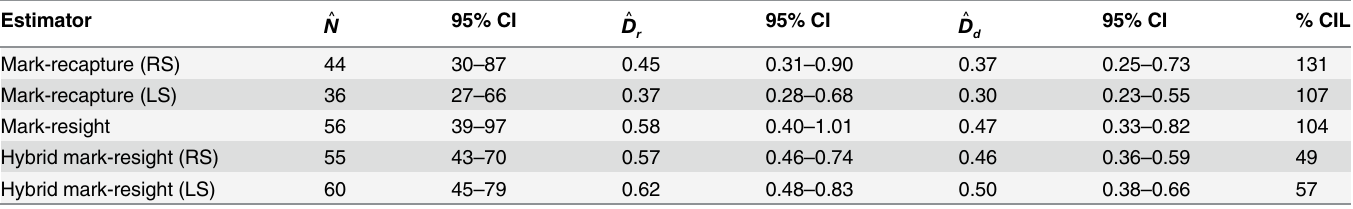
Table 1. Camera survey model-averaged mark-recapture and mark-resight bobcat Lynx rufus abundance ( N ^ ) and density/km 2 ( D ^ ) estimates in the San Joaquin Hills study area, Orange County, California.